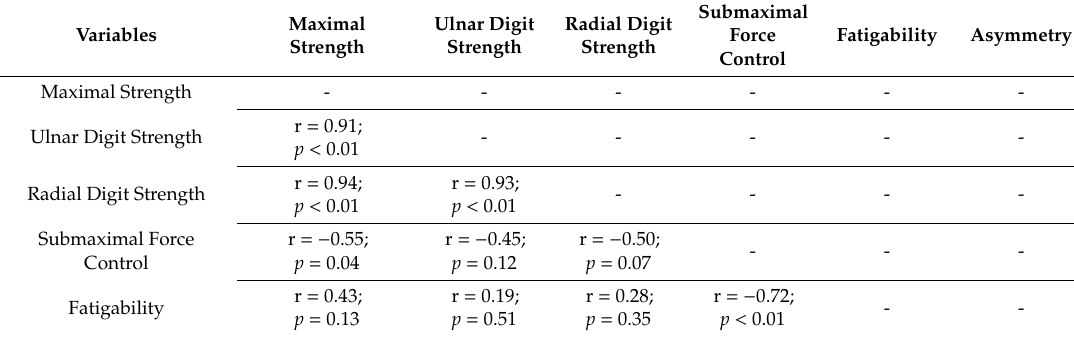
Table 2. Correlations between the handgrip strength